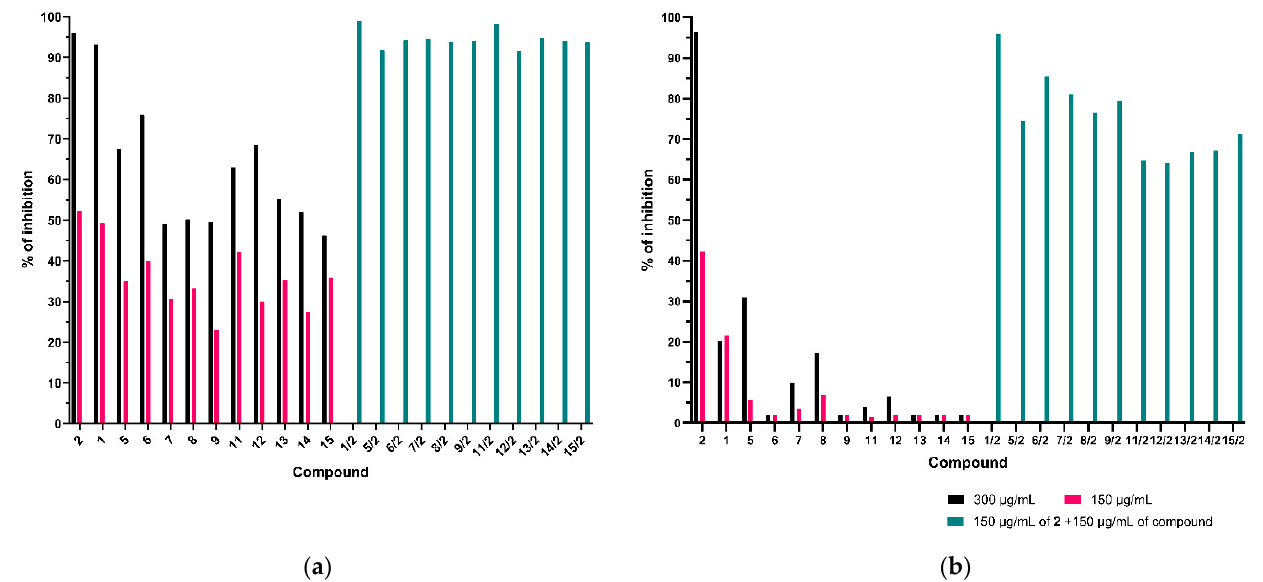
Figure 15. ( a ) Percent of inhibiting the growth of Candida albicans AM38/22 (MIC 90 > 256 µg/mL) by lactone 2 and azoles 1–9 , 11–15 alone and in combination lactone 2 with one of the azoles. ( b ) Percent of inhibiting the growth of Candida albicans AM38/680 (MIC 90 > 1024 µg/mL) by lactone 2 and azoles 1–9 , 11–15 alone and in combination lactone 2 with one of the azoles.